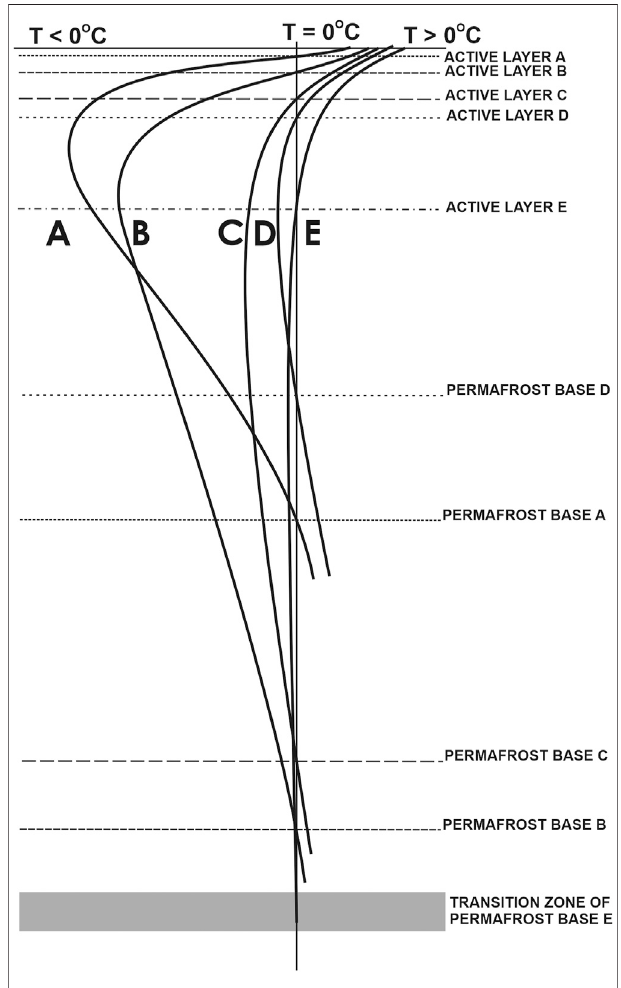
FIGURE 2 | Five selected theoretical permafrost thermal pro fi les. Notes: (A) — cold and thin permafrost layer, high thermal gradients from both directions, (B) — cold and thick permafrost layer, low thermal gradient from below, (C) — warm and thick permafrost layer with low thermal gradient from both sides, (D) — warm and thin permafrost with low thermal gradient from above, and (E) — The zero-gradient pro fi le, mean annual ground temperature is basically at 0 ° C or at the freezing temperature of